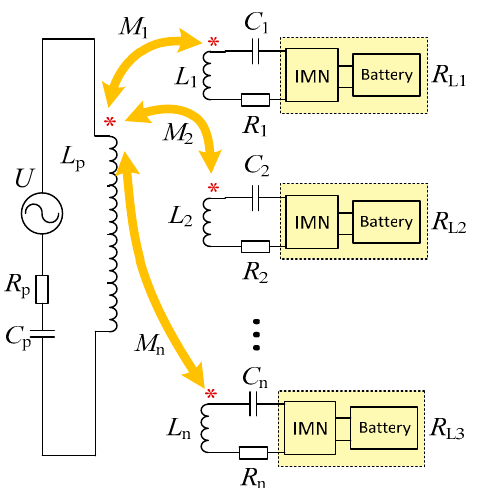
Figure 2. The equivalent circuit diagram of long-track EV (Electric Vehicle) DWPT (Dynamic Wireless Power Transmission) system.